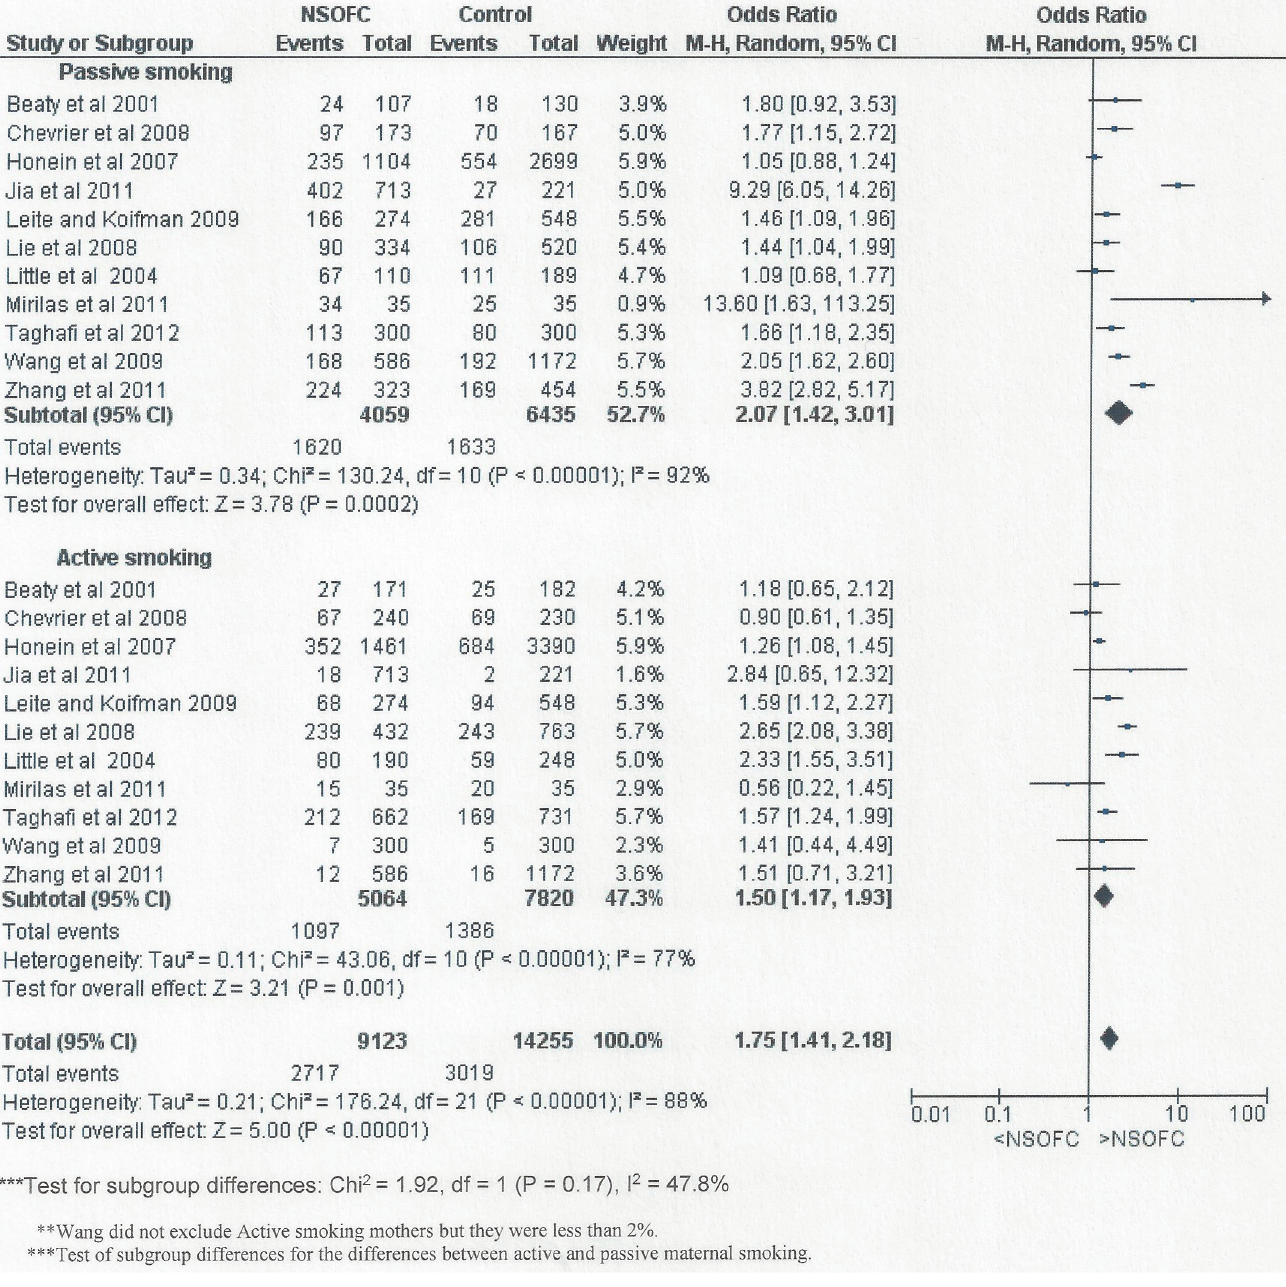
Fig 3. Forest plot for meta-analysis of the association between maternal passive smoking and the risk of having an infant with NSOFC, comparing the different types of maternal smoking exposure (active and